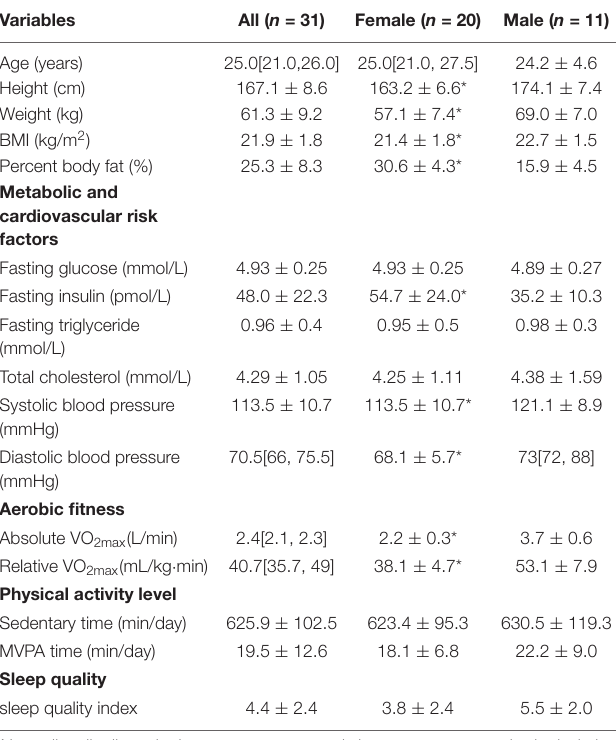
TABLE 1 | Participant